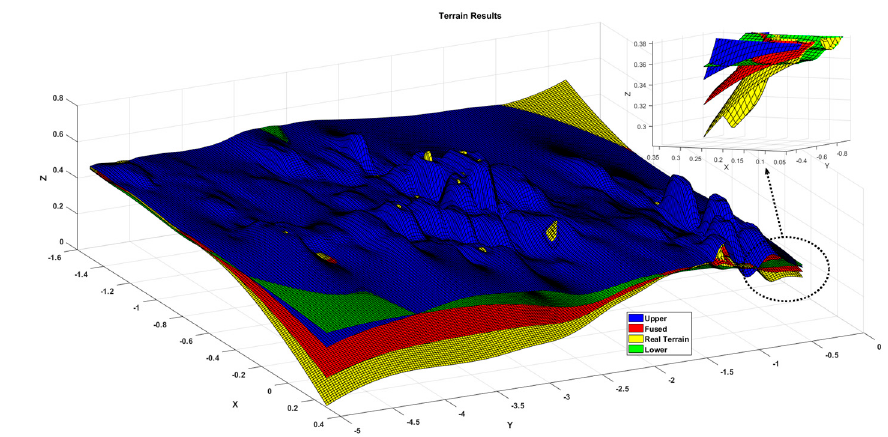
Figure 26. Comparative analysis of terrain mapping results.